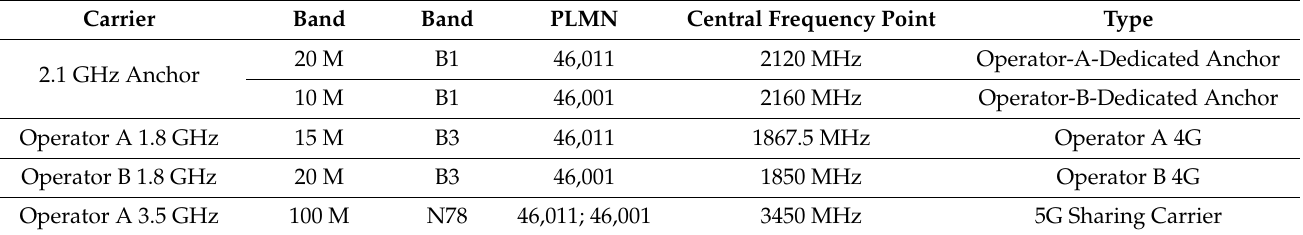
Table 2. Carrier Configuration.